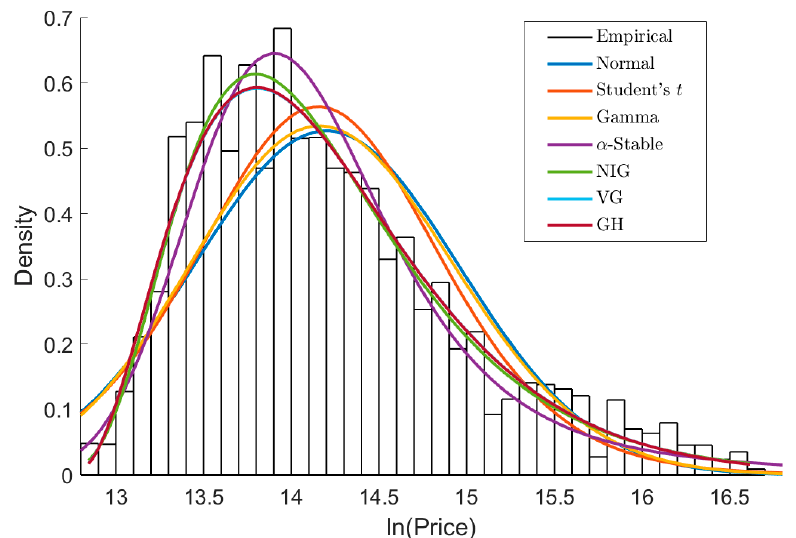
Figure 1. The fits (solid curves) of alternative distributions to the empirical log-price data (histogram) for NYC. (GH: generalized hyperbolic, VG: variance gamma, and NIG: normal-inverse Gaussian).